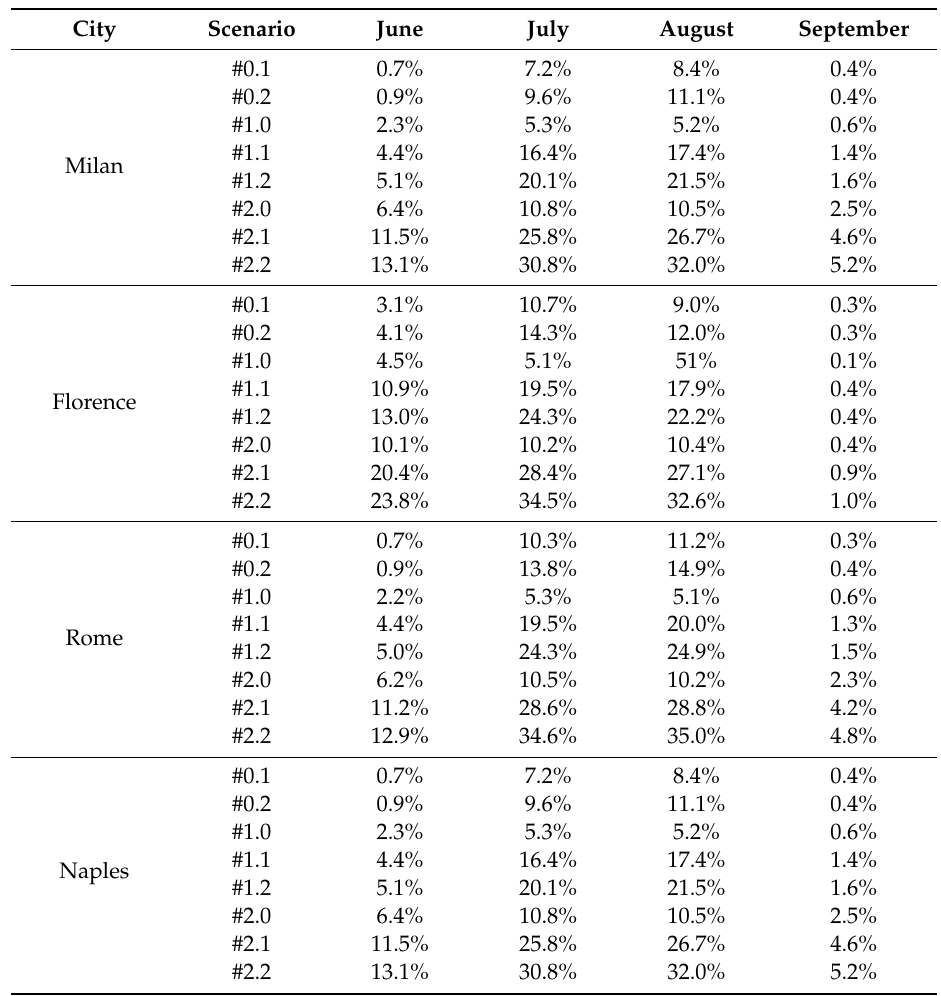
Table 4. Relative variations in electricity consumption compared to the base-scenario #0.0 in the summer